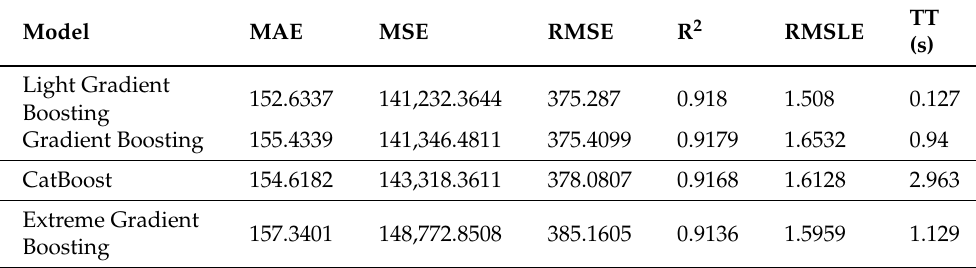
Table 1. Pycaret